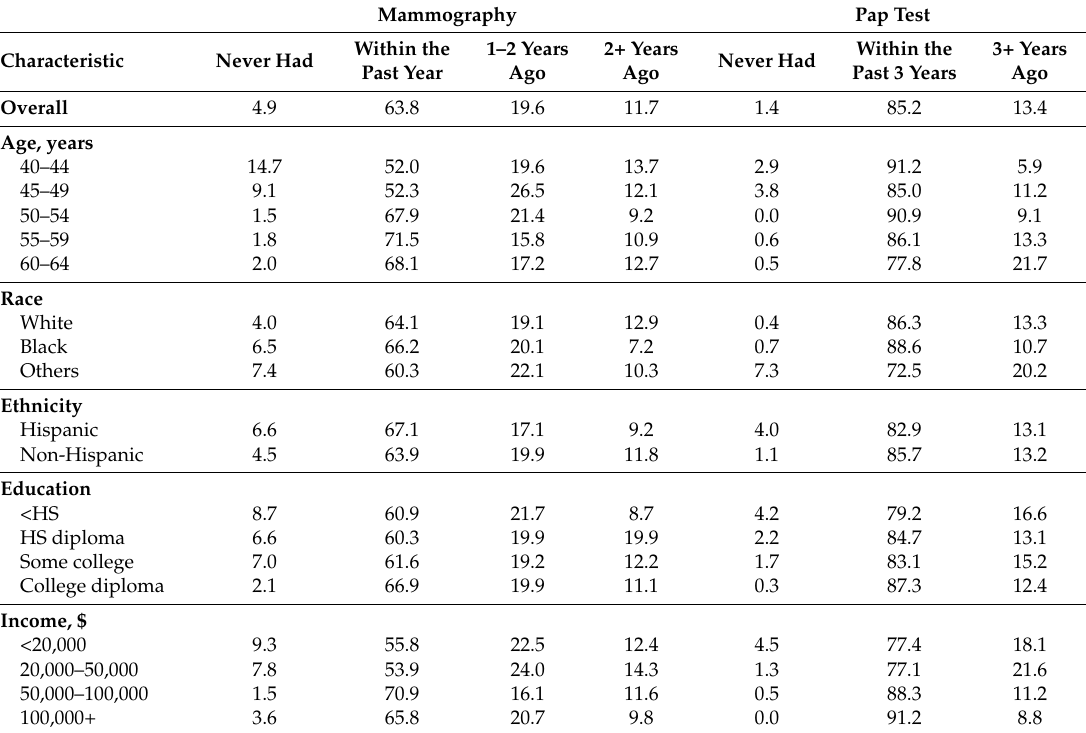
Figure 2. Estimated adherence rate for breast and cervical cancer screenings, United States, 2017. Note: Adherence rate was estimated based on American Cancer Society guideline published in 2015 (breast cancer) and in 2012 (cervical cancer). Charts in box represent the age groups that should receive both screenings. Breast cancer screening among the women aged 40–44 years were individual-based choices; therefore, not presented here. Age-specific estimates were calculated using the proportions of adherent women in each age group. Table 2. Prevalence estimates of mammography and Pap test (%), Women 40–64, United States,